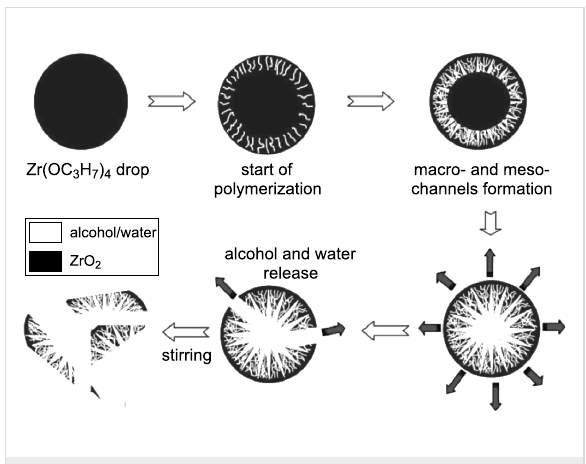
Figure 8: Schematic representation of the formation of micro-meso- macroporous metal oxides (zirconia) [154]. Reproduced by permission of The Royal Society of